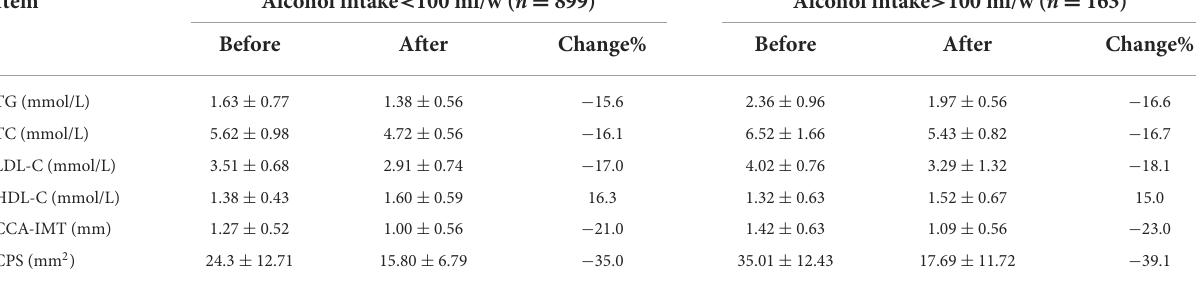
TABLE 10 Comparison of the effects of NK on the lipid profile and progression of atherosclerosis in alcohol and non-alcohol drinkers.